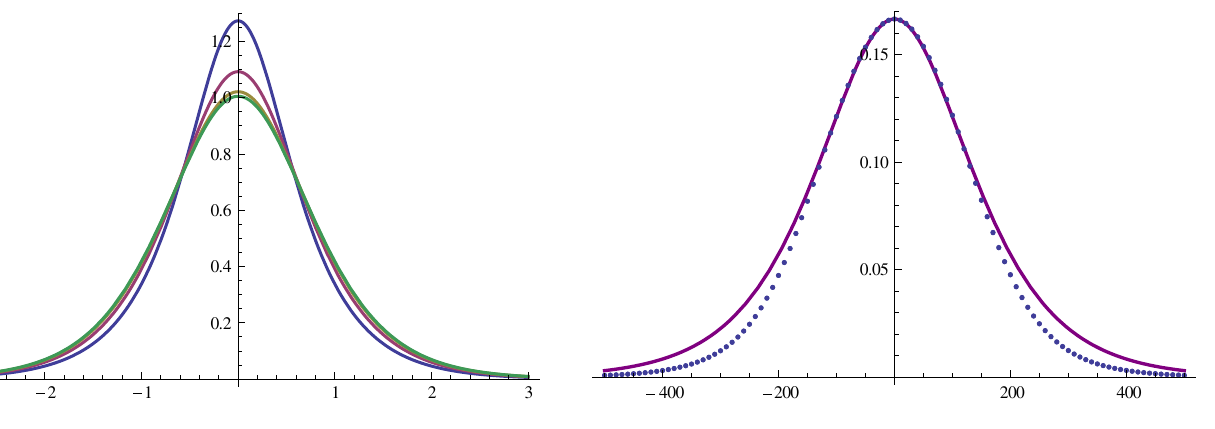
FIG. 2. F x =x vs z for x ¼ (cid:3)= 4 (blue), 0.5 (purple), 0.25 (brown), and 0.125 (green).